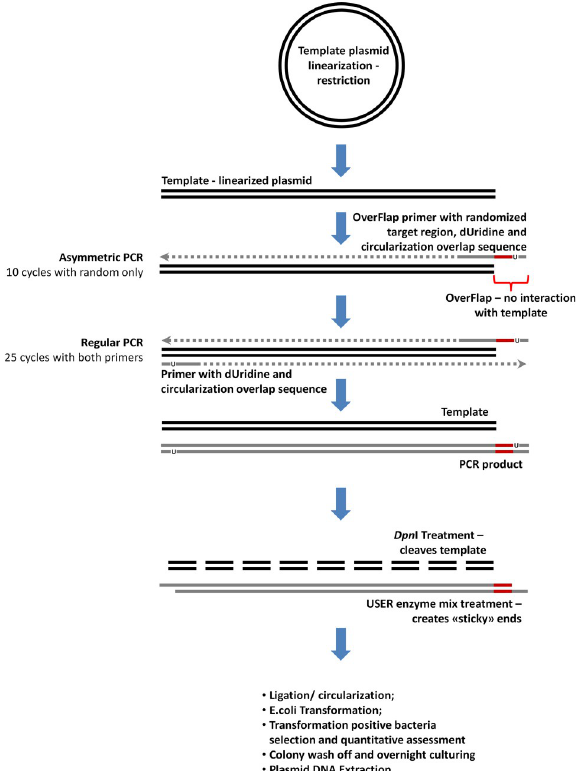
Fig 2. The principal scheme of the OverFlap strategy for whole plasmid amplification-based randomization of the selected plasmid DNA region. The methodological approach following circularization is identical to the one described in Fig 1. However, here the plasmid is linearized in a way that the random region of the longer primer does not interact with the template, and an additional stage of asymmetric PCR with only a random region containing a primer is performed to increase the number of sequence variants within the final library. U represents deoxyuridine within the employed primers. The red, black, grey, dotted, and dashed lines represent the randomized region, template DNA, the synthesized chain, DNA synthesis, and template DNA degradation by Dpn I restriction endonuclease, respectively.